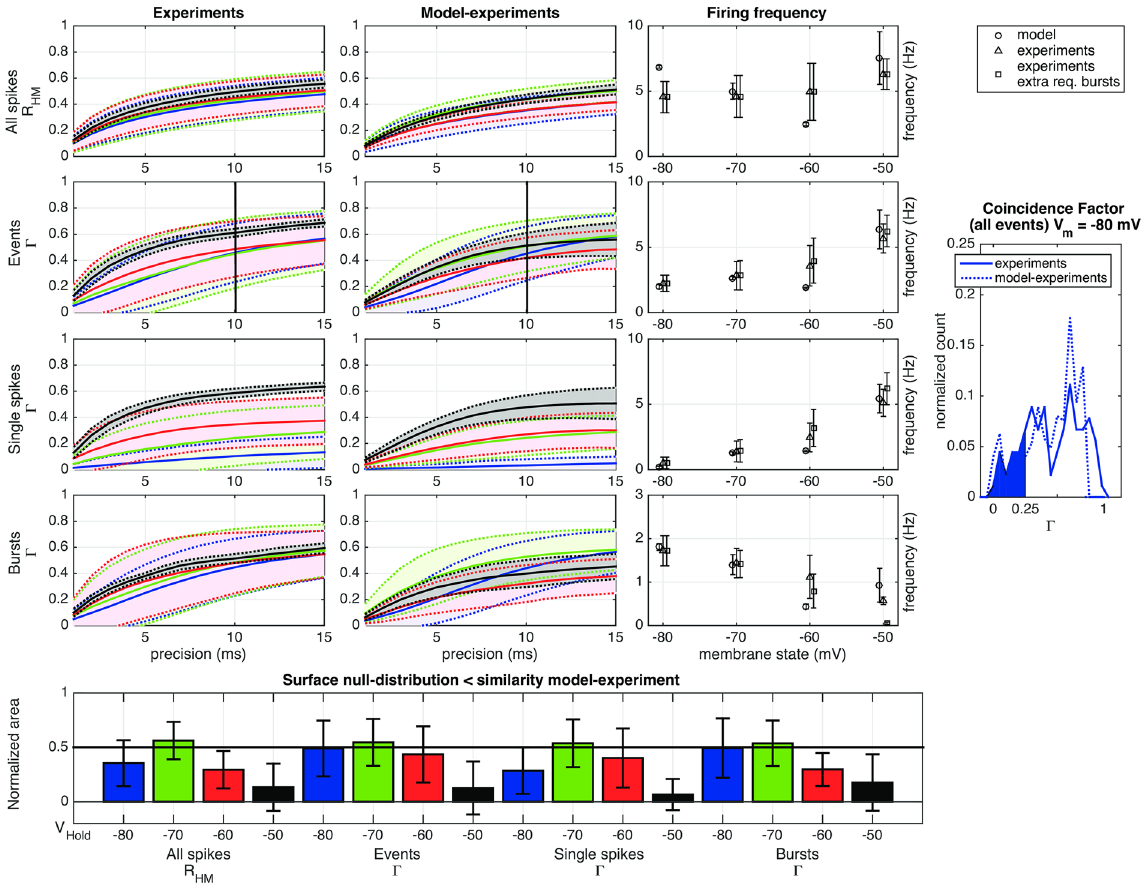
Fig 10. Comparing model and experimental spike trains. Left two columns: reliability (coincidence factor Γ or Hunter and Milton measure R HM ) between experimental traces as a function of precision at different membrane states (blue: − 80 mV, green: − 70 mV, red: − 60 mV, black: − 50 mV). The shaded areas and dotted lines denote the standard deviations. The four rows represent the different types of activity: all spikes, all events (isolated spikess and bursts), isolated spikes and finally bursts. Second column: reliability between the model traces and the experimental traces. Third column: event frequencies for the model, the experiments without the extra requirement for bursts, and with the requirement (details in Materials and methods). Right panel: distribution of the reliability values among experiments (solid line) and between model and experiments (dashed line) of bursts at a precision of 10 ms (denoted by lines at this precision, see also S1 Fig). The (dis)similarity between between experimental spike trains on the one hand and the model and the experimental spike trains on the other, was established as follows: we established the null-distribution of experimental reliability values. Next, we calculated the surface of this null-distribution up to each model- experiment reliability value (shaded area). The bottom panel gives the values of these surfaces. If experimental and model spike trains were drawn from the same distribution, the expectation value of the mean surface would be 0.5, indicated by the horizontal line. Error bars indicate standard deviations.